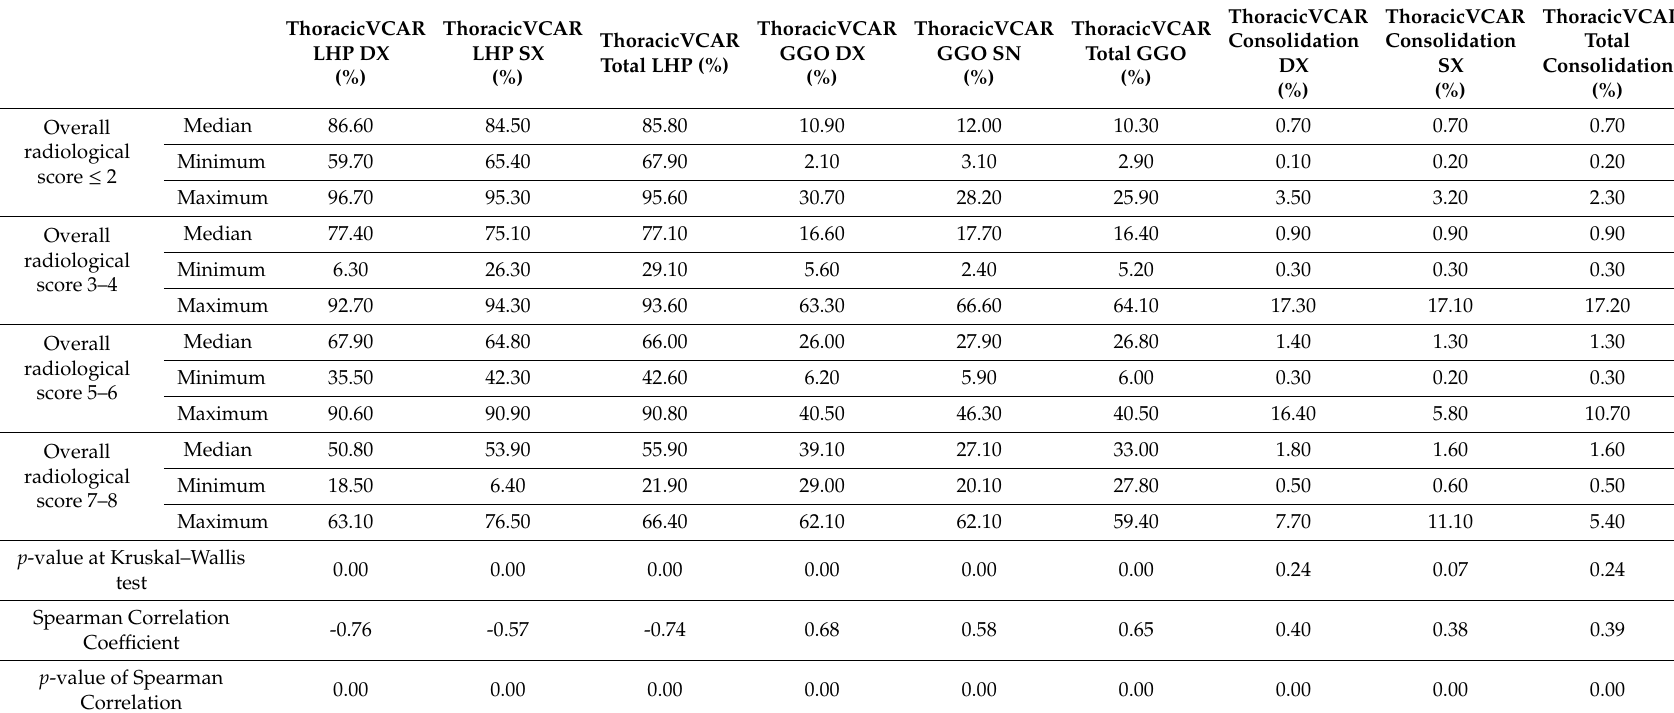
Table 4. ThoracicVCAR quantitative results compared with radiological